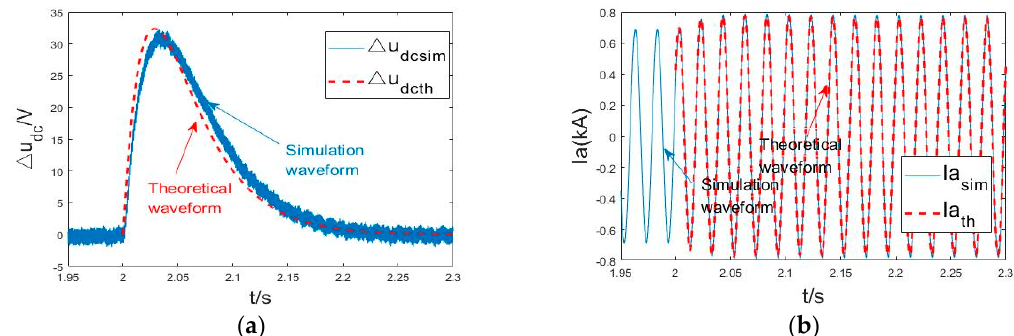
Figure 7. ( a ) Waveforms of three-phase voltage. ( b ) Waveforms of d , q -axis voltage.